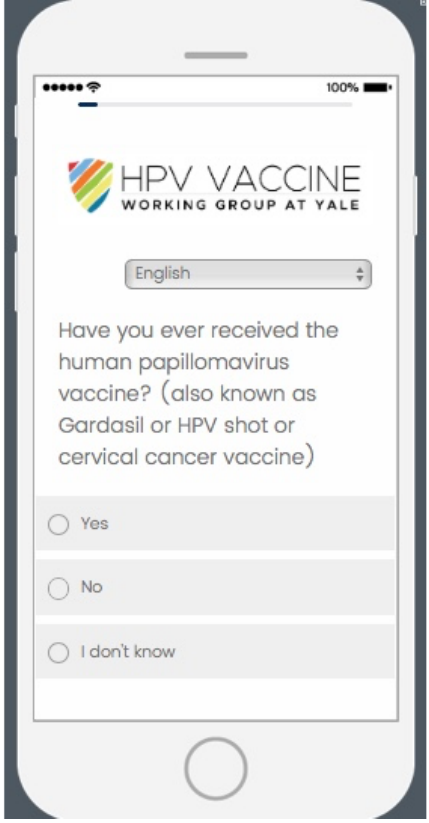
Figure 1. Representative screenshot of the